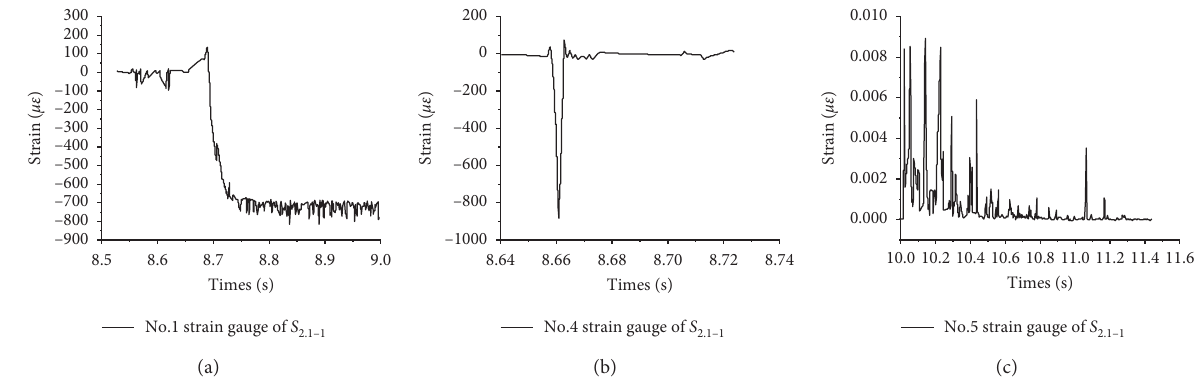
Figure 21: S 2.1-1 strain time chart of different strain gauges: (a) No. 1 strain gauge; (b) No. 4 strain gauge; (c) No. 5 strain gauge.